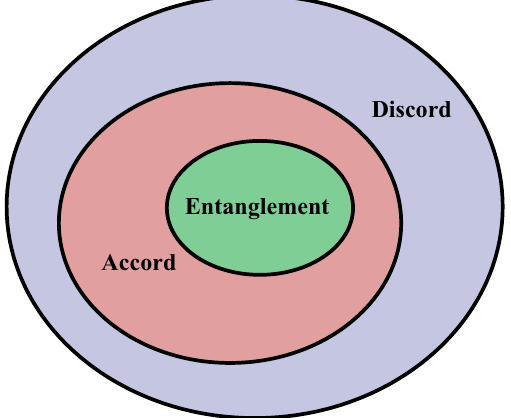
Figure 1. Schematic representation of the correlation hierarchy. All entangled states have a finite value of accord and all states with accord have a finite value of discord whereas the contrary statements are not